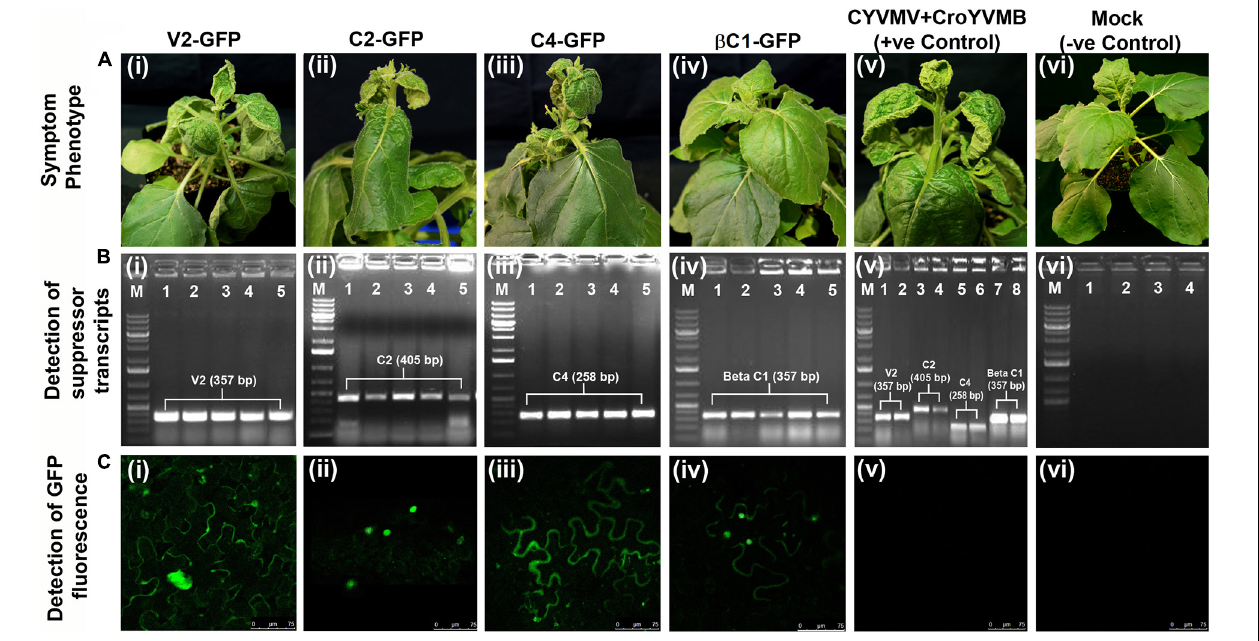
FIGURE 10 | Pathogenicity determination assays of the four silencing suppressors from CYVMV or CroYVMB. Pathogenicity induced by V2, C2, C4, or β C1 was determined via agroinfiltrating their respective overexpression constructs (fused with eGFP in pEarleyGate103) to N. benthamiana leaves. Five plants were infiltrated for each construct. (A) Variable leaf curl symptoms can be detected in plants infiltrated with V2-GFP, C2-GFP, or C4-GFP constructs (Ai–iii) but not β C1-GFP-infiltrated plants (Aiv) . CYVMV and CroYVMB infiltrated (i.e., the positive control) plants also showed similar symptoms (Av) . As expected, no